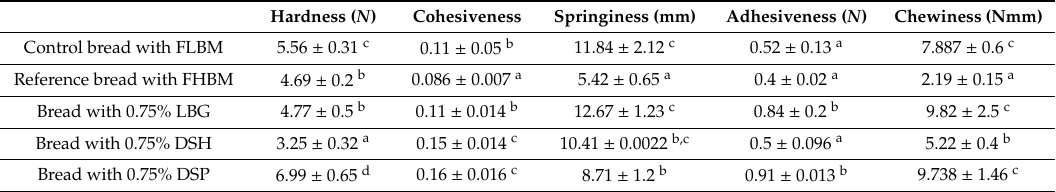
Table 4. The e ff ect of DSP and DSH addition on the textural properties (hardness, cohesiveness, adhesiveness, springiness, and chewiness) of